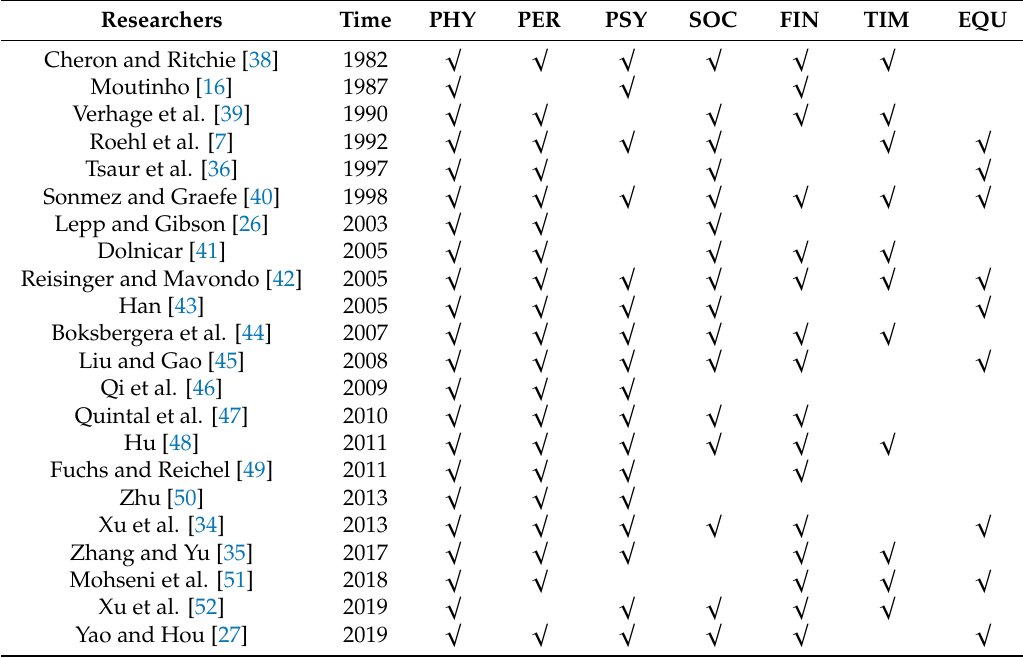
Table 1. Dimensions of tourism risk perception from